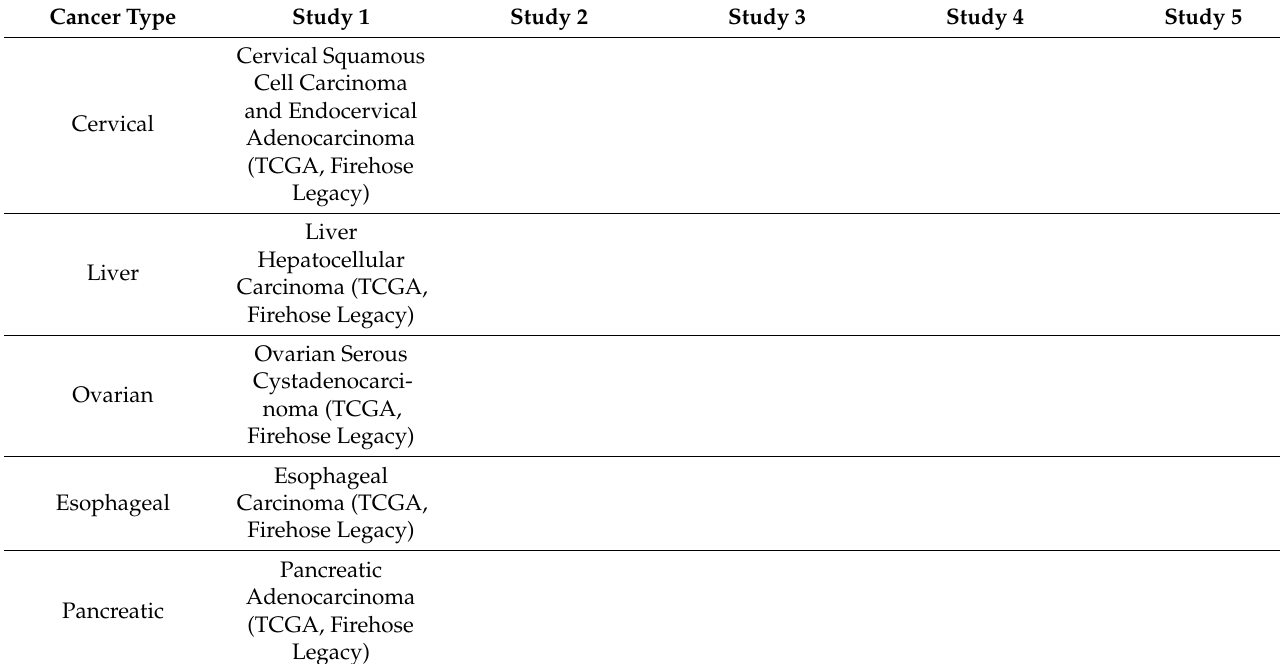
Table 6. Studies included from cBioPortal at the initial screening stage. N.B. Uveal melanoma was excluded from all melanoma analyses due to this cancer’s known poor response to immune checkpoint blockade compared to cutaneous melanoma